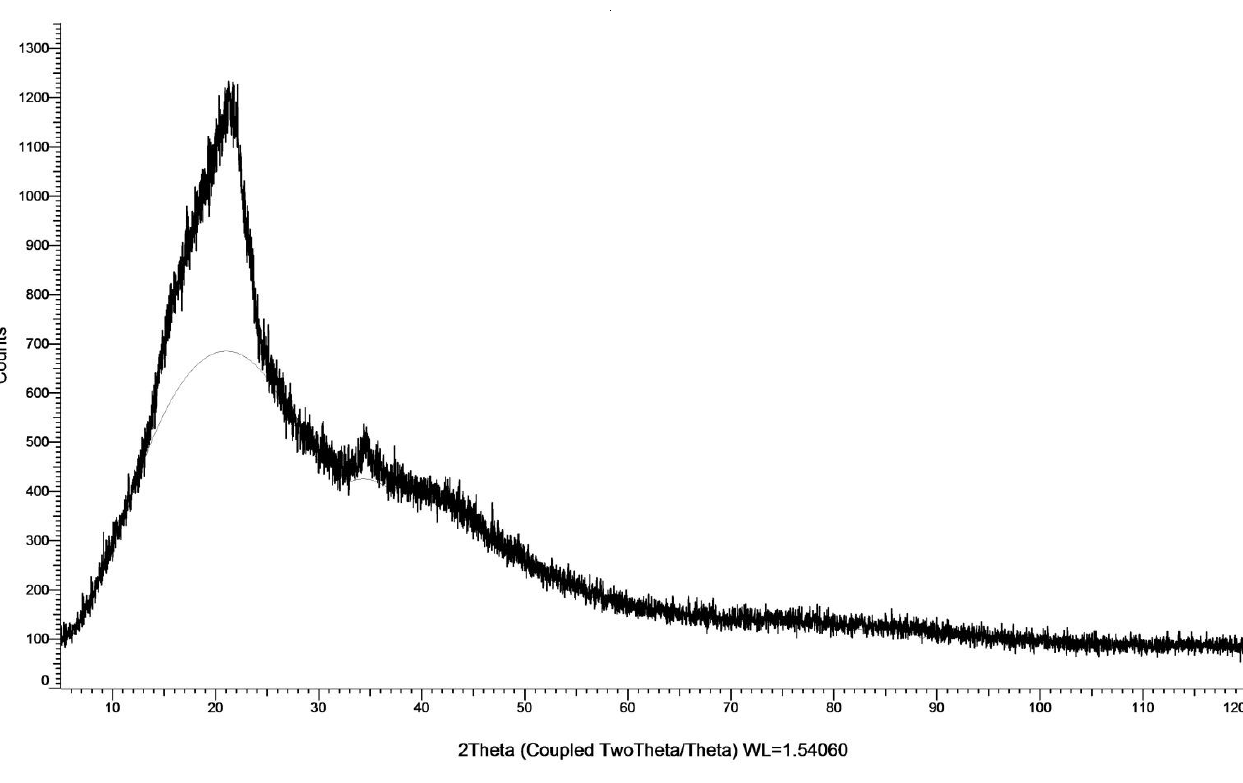
Figure 4. XRD pattern of corn silk powder. Figure 4. X-ray diffraction pattern of corn silk